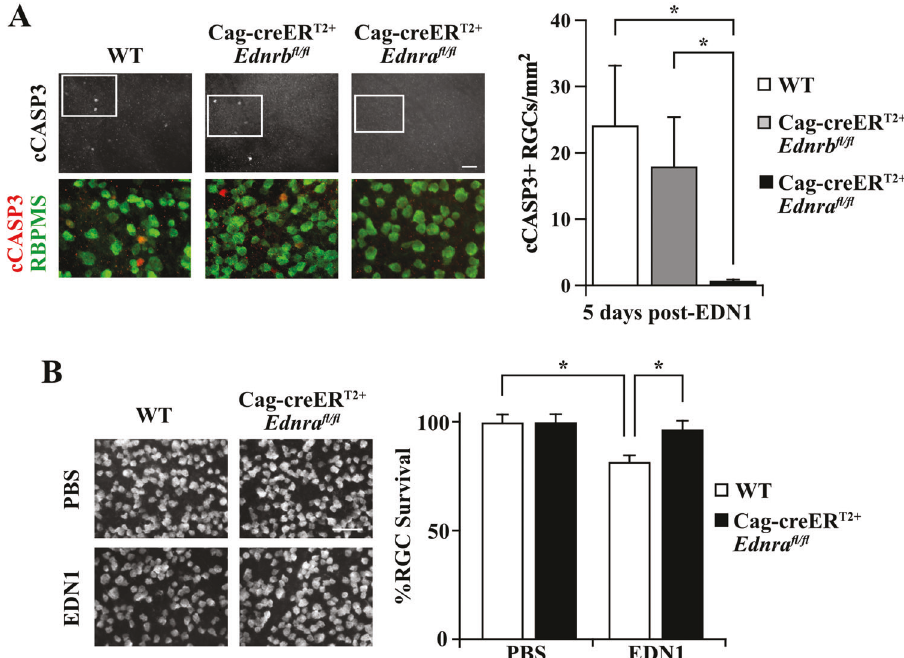
Fig. 3 EDN1 ligand acted through EDNRA to drive RGC death. A Retinal fl at mounts from WT, Cag-creER T2 + Ednrb fl / fl , and Cag-creER T2 + Ednra fl / fl mice immunoassayed for cCASP3 and RBPMS 5 days post-EDN1. Cag-creER T2 + Ednrb fl / fl retinas had similar numbers of cCASP3 + RGCs compared to WT controls, while Cag-creER T2 + Ednra fl / fl mice had signi fi cantly reduced cCASP3 + RGCs compared to both WT and Cag-creER T2 + Ednrb fl / fl retinas. cCASP3 + RGCs/mm 2 ± SEM: WT: 24.2 ± 8.9 Cag-creER T2 + Ednrb fl / fl : 18.0 ± 7.4, Cag-creER T2 + Ednra fl / fl : 0.7 ± 0.1 ( n ≥ 6, * P < 0.01, Kruskal-Wallis test). Scale bar, 50 μ m. B Flat mounted WT and Cag-creER T2 + Ednra fl / fl retinas immunoassayed for RBPMS 28 days post-EDN1 injection. Full body deletion of Ednra prevented EDN1-induced RGC loss. %RBPMS + cell survival±SEM for WT and Cag-creER T2 + Ednra fl / fl respectively: PBS: 100.0 ± 3.4, 100.0 ± 2.7; EDN1: 82.0 ± 2.7, 97.0 ± 3.8 ( n ≥ 6, * P < 0.05, two-way ANOVA, Holm – Sidak post hoc). Scale bars, 50 μ